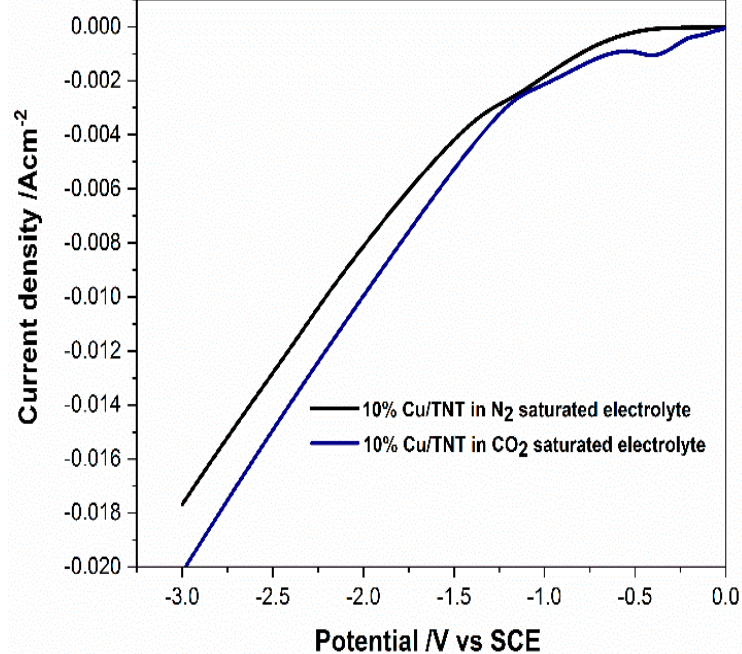
Figure 6. Linear sweep voltammetry for 10% Cu/TNT in the presence of N2 and Co2 saturated aqueous 0.5 NaHCO